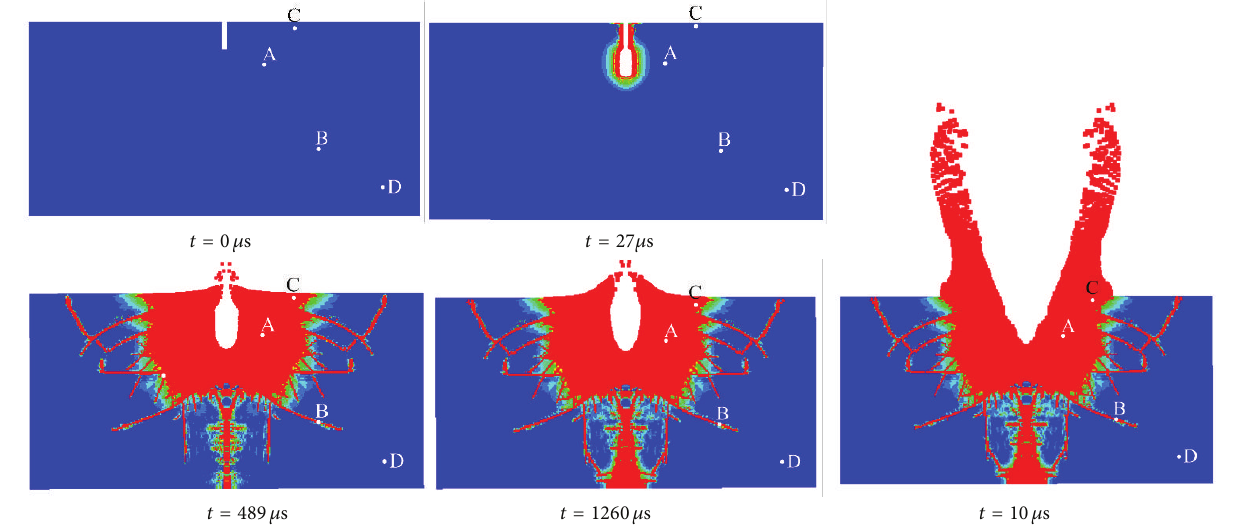
Figure 2: The pattern of damage in the process of concrete fractured.